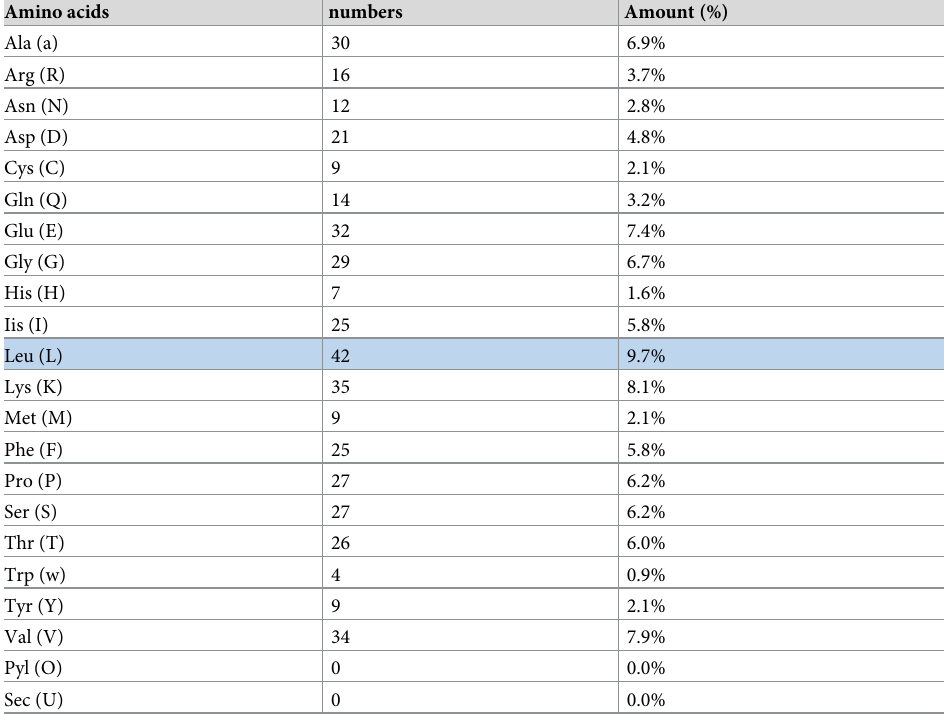
Table 2. A glance at the prediction of simple physicochemical specifications (amino acids composition) of the T5AT protein. The amount of amino acid leucine (Leu) in the T5AT protein structure was the most. Amino